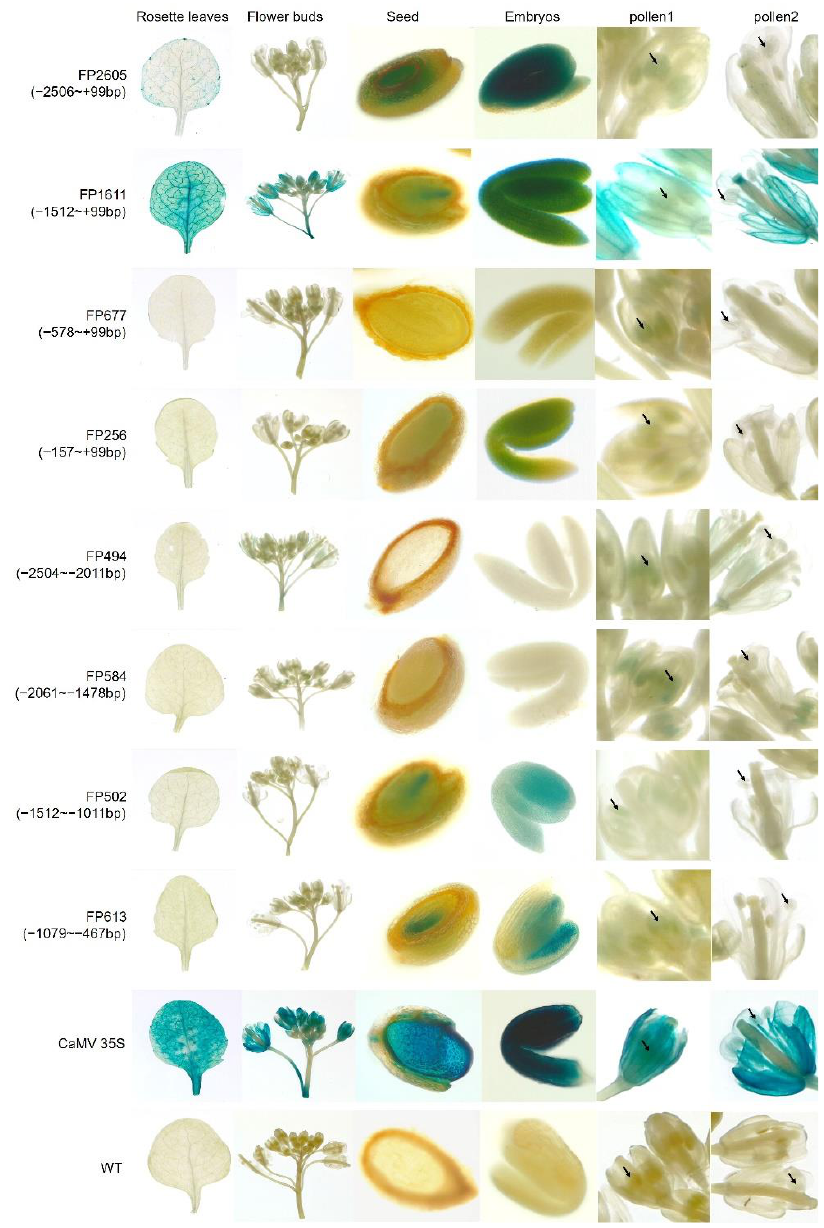
Figure 2. The GUS expression analysis in the transgenic plant containing different deletion fragments of the RcFAH12 promoter. GUS staining results of different promoter fragments driving GUS gene expression in rosette leaves, flower buds, seeds, and embryos. CaMV 35S promoter as a positive control, wild type Arabidopsis thaliana without GUS gene as a negative control. Pollen1 and Pollen2 are enlarged images of early flowers and late flowers flower buds, respectively. (Arrows indicate the location of one of the anthers). CaMV35S strongly promoted the GUS reporter gene in all tissues.